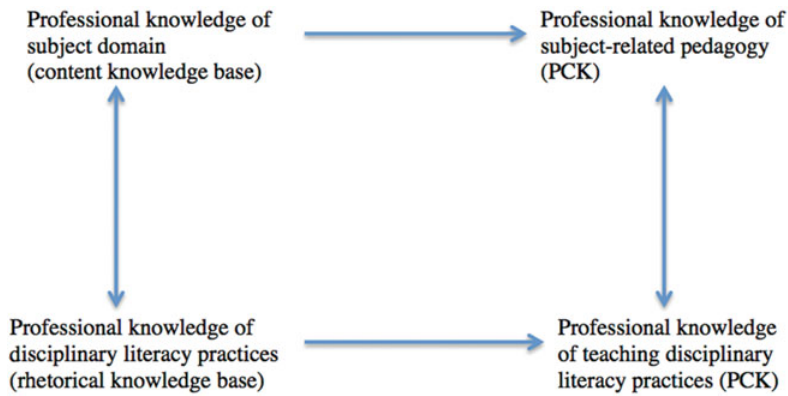
FIGURE 1. (Colour online) Professional and metalinguistic